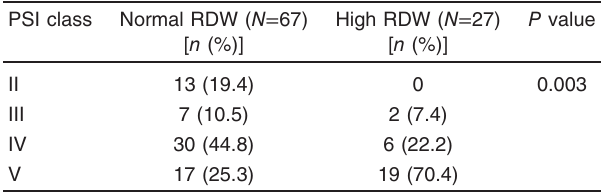
Table 2 Distribution of red cell distribution width based on Pneumonia Severity Index